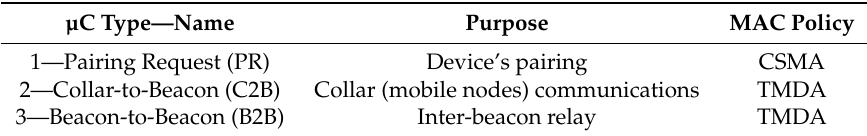
Table 2. Micro-cycles types currently defined [72].